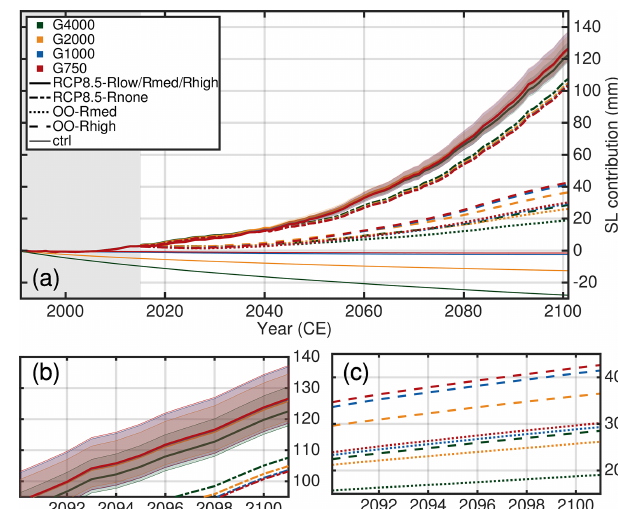
Figure 6. Projected sea-level contribution of the Greenland ice sheet based on MIROC5 RCP 8.5 climate data (a) . Coloured lines indicate the different grid resolutions employed, while the individ- ual scenarios are indicated with different line styles. The mass loss trends are corrected with the ctrl run relative to the reference time. The grey-shaded box shows the historical period. (b) Enlargement of the RCP8.5-Rlow, RCP8.5-Rmed, RCP8.5-Rhigh and RCP8.5- Rnone scenarios. (c) Enlargement of the OO-Rmed and OO-Rhigh